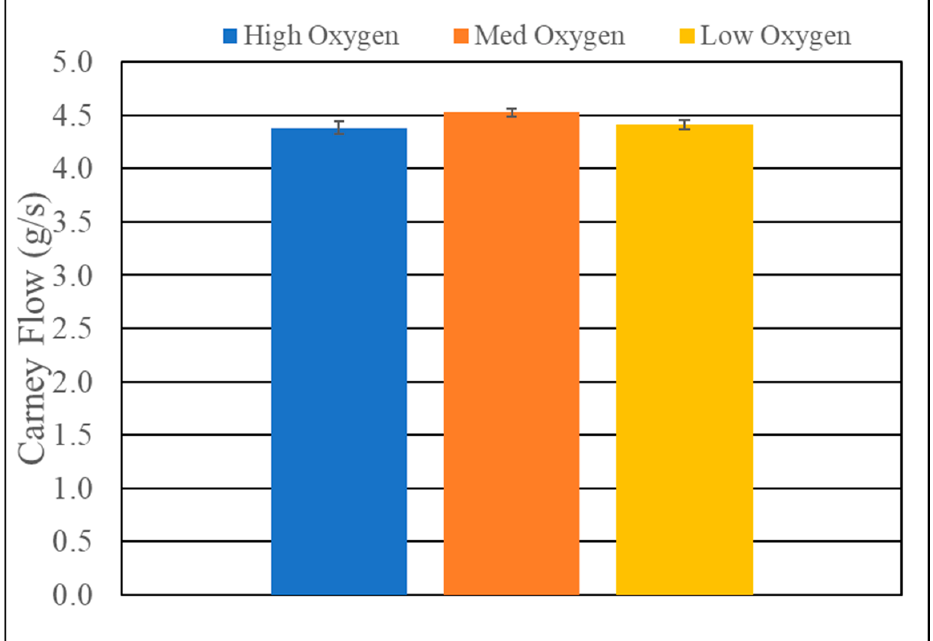
Figure 20. Carney flow data for evaluated AL6061 powders.